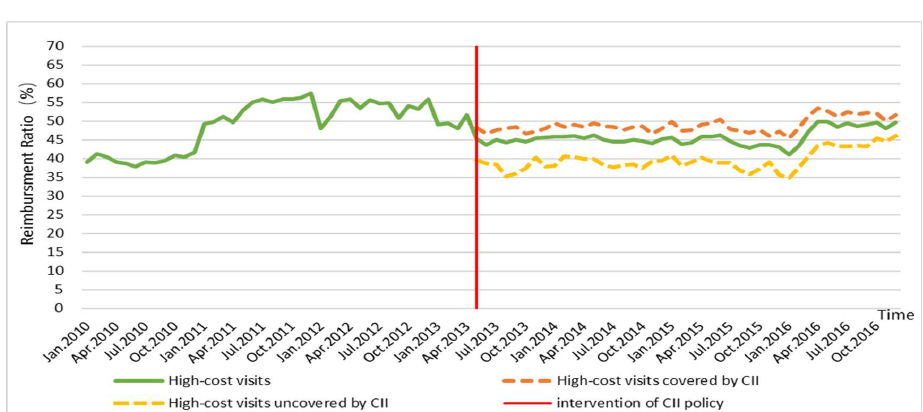
Figure 2. Trends of out-of-pocket (OOP) expenses in 2010–2016.